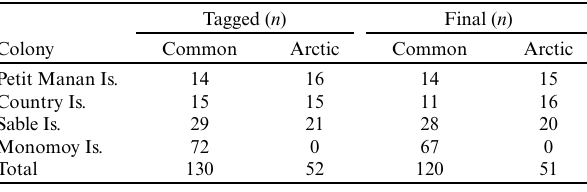
Table 1 . Sample sizes ( n ) of Common ( Sterna hirundo ) and Arctic ( S. paradisaea ) Terns fitted with digital VHF transmitters at four colonies in the western North Atlantic in 2013. Tagged ( n ) indicates the starting sample size, and Final ( n ) indicates the sample sized retained for subsequent analyses after removing (and in some instances redeploying) transmitters that were